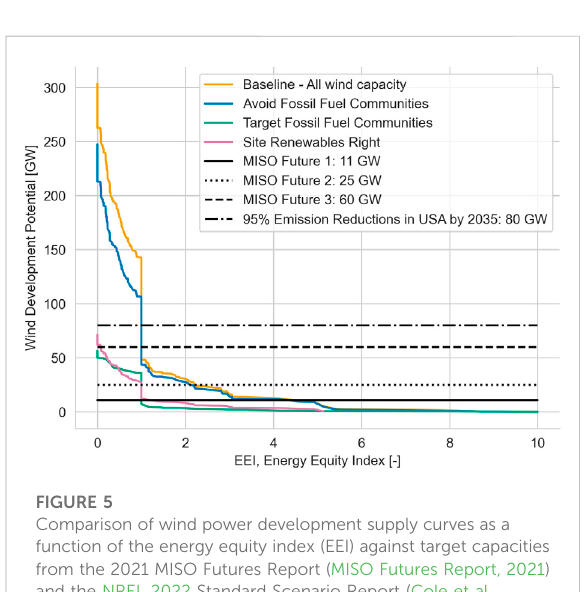
FIGURE 5 Comparison of wind power development supply curves as a function of the energy equity index (EEI) against target capacities from the 2021 MISO Futures Report (MISO Futures Report, 2021) and the NREL 2022 Standard Scenario Report (Cole et al.,